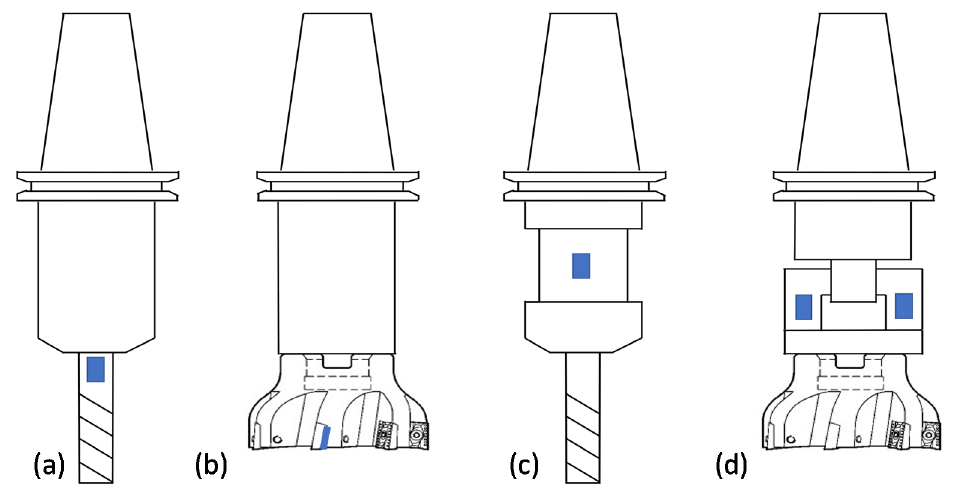
Figure 5. Various concepts of thin film placements as indicated by the blue spots: ( a ) on the tool [93,94] , ( b ) under the insert [102] , ( c ) on a reduced diameter of the tool holder [106] , and ( d ) on an ( b ) under the insert [102], ( c ) on a reduced diameter of the tool holder [106], and ( d ) on an integrated integrated flexible body [91] . flexible body